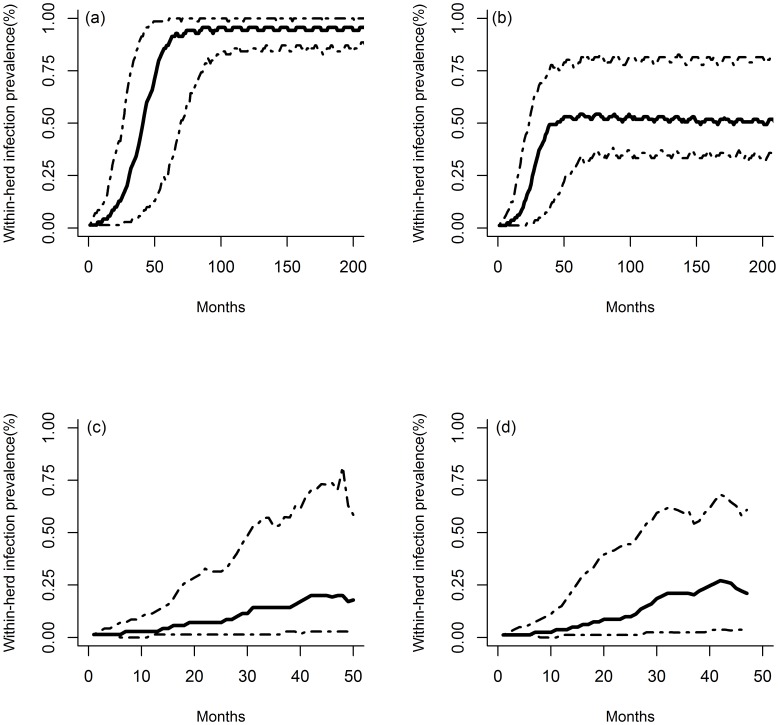
Monthly evolution of the simulated proportion of infected animals (animals in E or I health state; solid line: median, dashed: 2.5% and 97.5% percentiles) in standard French beef (a and c, 70 animals) and dairy (b and d, 81 animals) herds without (a and b) or with (c and d) implementation of control program B (1,000 simulations per scenario).